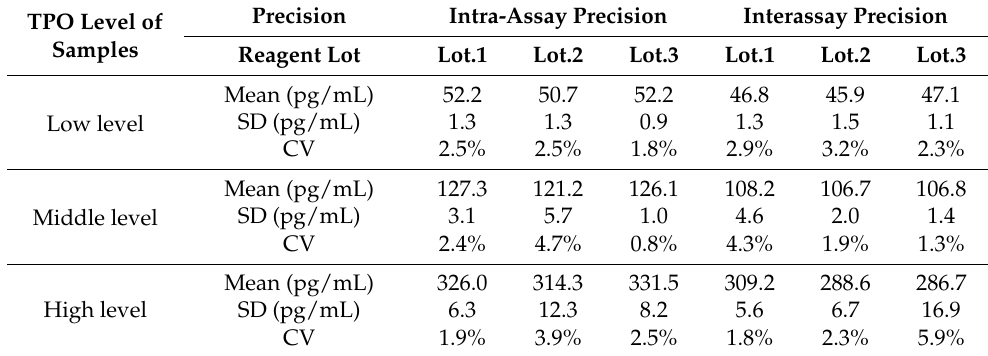
Table 2. Intra- and interassay validations.